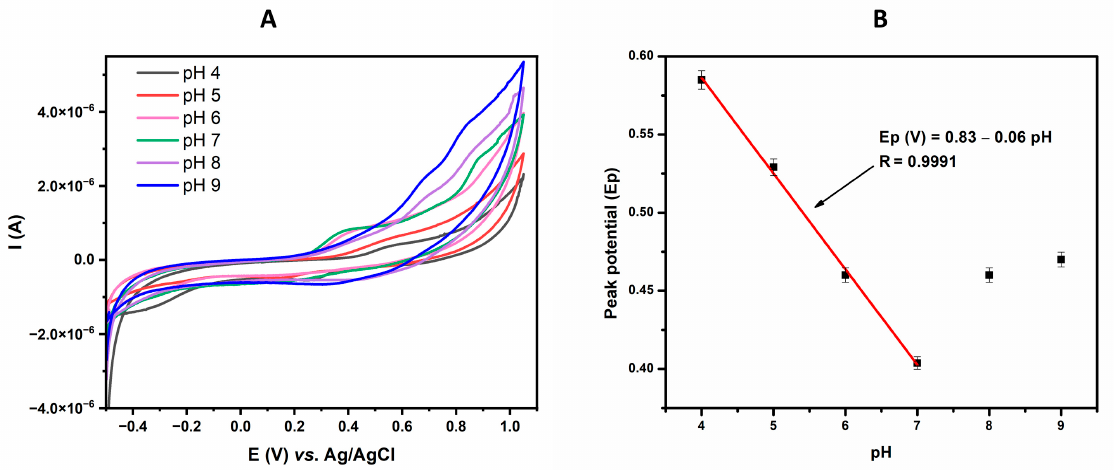
Figure 4. ( A ) CV current response for Eu 2 O 3 @Cr 2 O 3 /CPE at various concentrations of L-DOPA (1 mM–5 mM) at pH = 7.0 (BRBS) at a scan rate of 0.05 V s − 1 . ( B ) The corresponding linear calibration plot for the anodic peak current versus concentrations of L-Dopa. ( C ) CV current response of Eu 2 O 3 @Cr 2 O 3 /CPE at various scan rates (0.02–0.15 V s − 1 ) in BRBS (pH 7.0) with 100 µM of L-Dopa. ( D ) The corresponding plot for redox peak current values against scan rates.